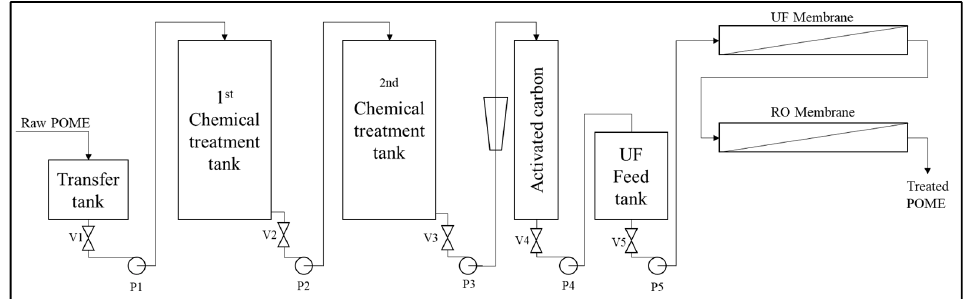
Figure 11. Schematic diagram of membrane technology for POME treatment. Adapted with permission from ref. [59]. Copyright 2003 Elsevier.